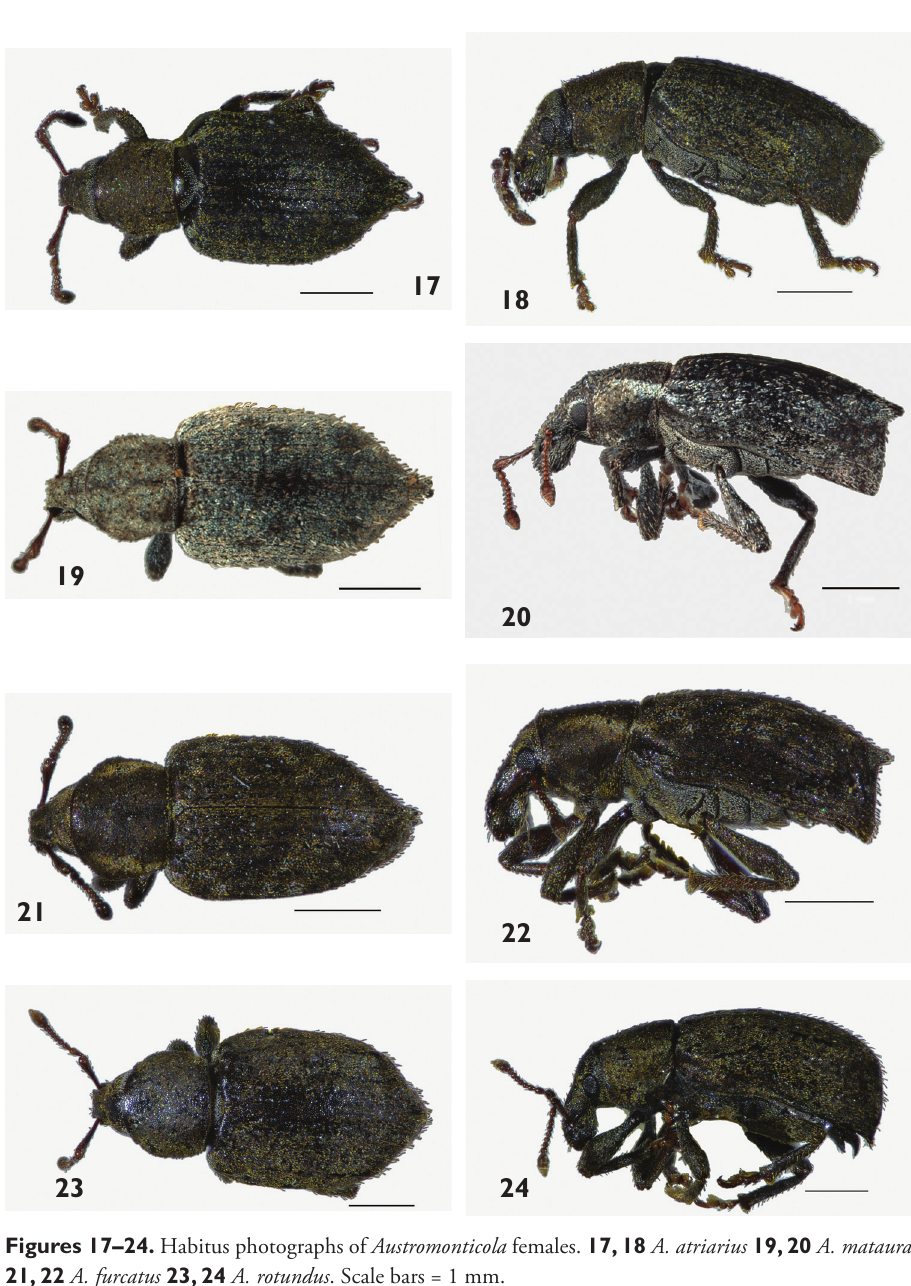
Figures 17–24. Habitus photographs of Austromonticola females. 17, 18 A. atriarius 19, 20 A.